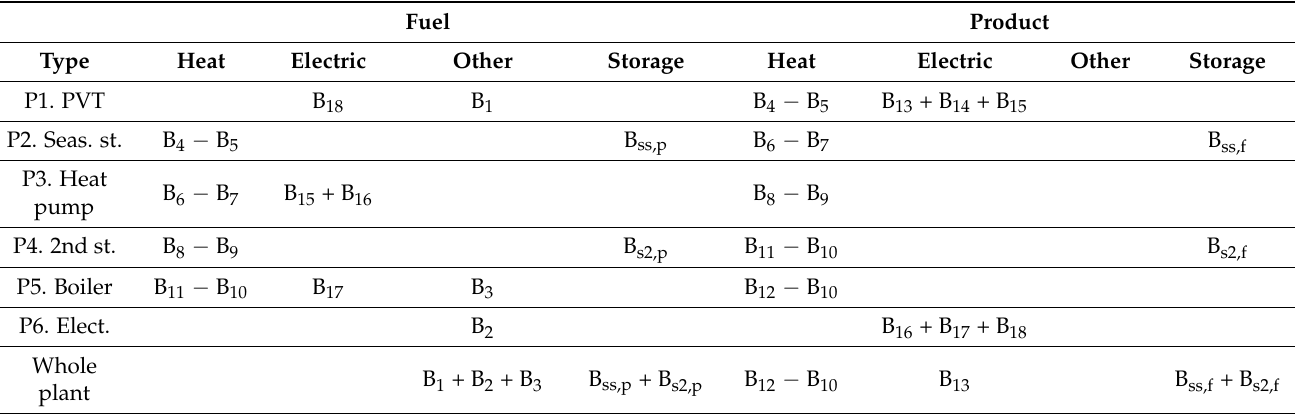
Table 1. Fuel and product definition.